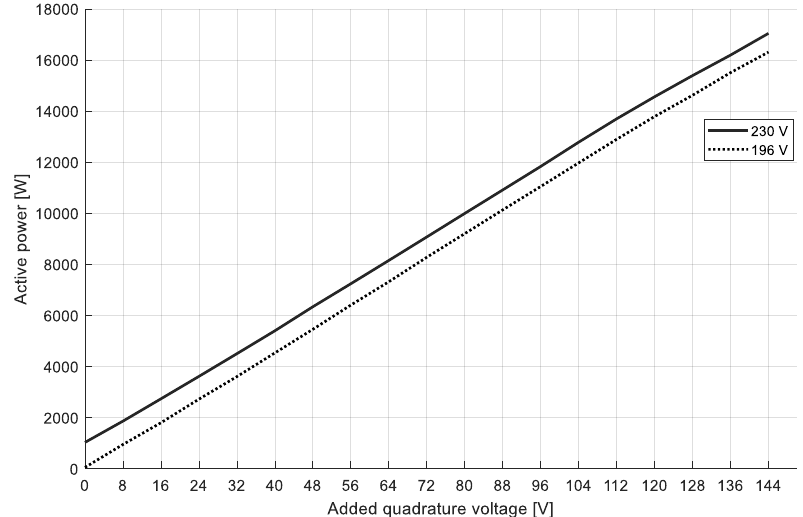
Figure 10. Measured active power flows versus injected quadrature voltage for analyzed two cases of longitudinal voltages.